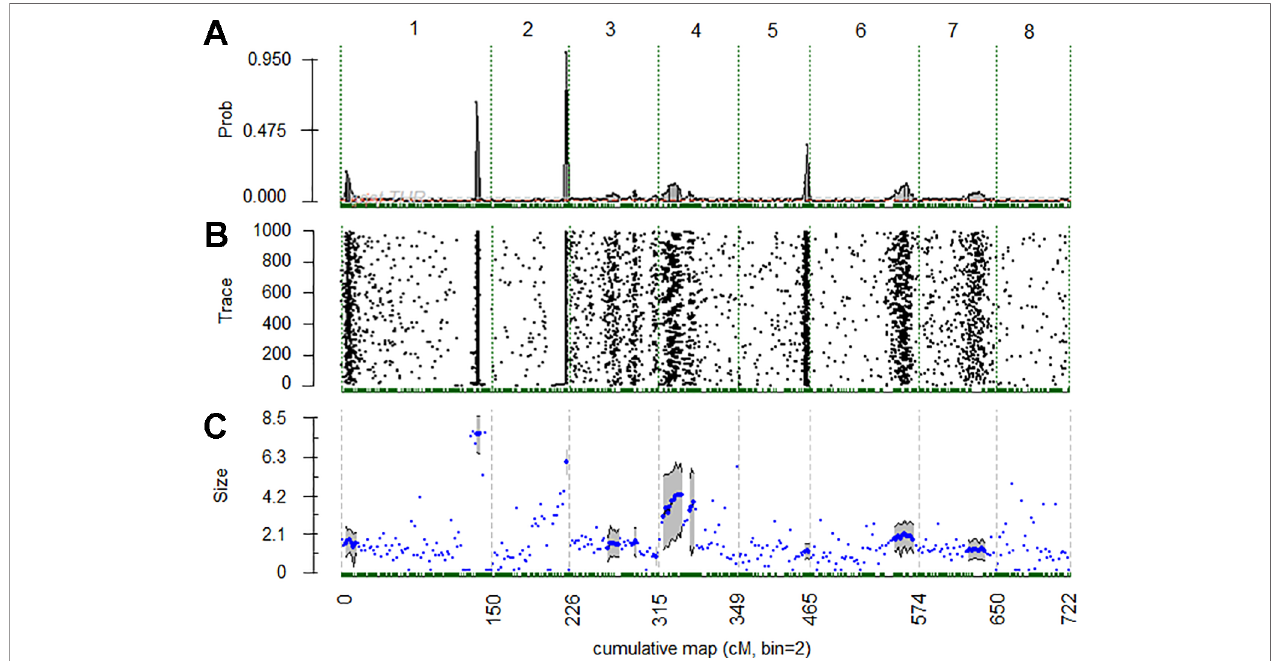
FIGURE 3 | (A) Posterior probabilities of quantitative trait loci (QTL) positions along the genome with a 2 cM bin resolution. (B) Trace plot of Markov chain Monte Carlo samples for QTL position. (C) Posterior mean (blue dots) and 90% credible region (gray shade) for estimate additive QTL effects for chromosomal regions of 2 cM bins with positive evidence (2lnBF10 > 2) for QTL presence. Vertical dashed lines identify the starts and ends of